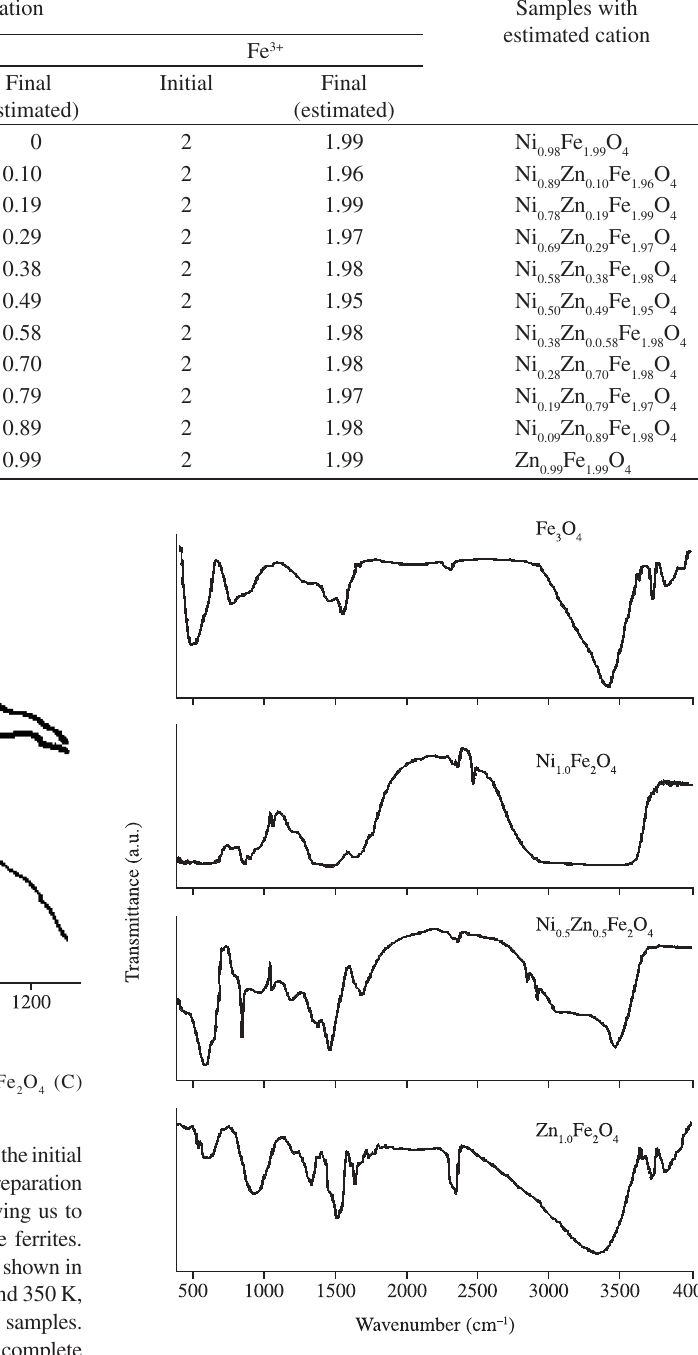
O and for uncoated Ni 3 4